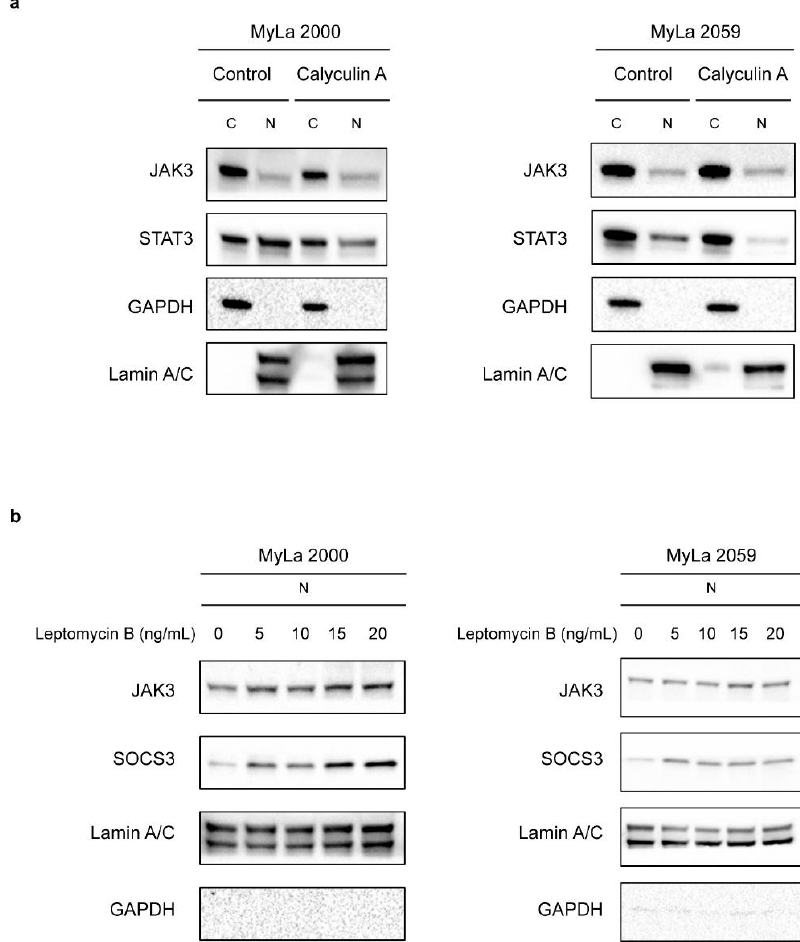
Figure 4. CRM1 inhibitor but not PP2A inhibitor has an effect on nuclear translocation of JAK3. ( a ) Immunoblot shows JAK3 expression in the cytoplasmic (C) and nuclear (N) extracts of MyLa 2000 (left) and MyLa 2059 (right) after treatment with either DMSO (Control) or 80 nM Calyculin A for 1 h. ( b ) Immunoblot shows JAK3 expression in the nuclear extracts (N) from MyLa 2000 (left) and MyLa 2059 (right) after treatment with mentioned concentrations (0–20 ng/mL) of Leptomycin B for 3 h.